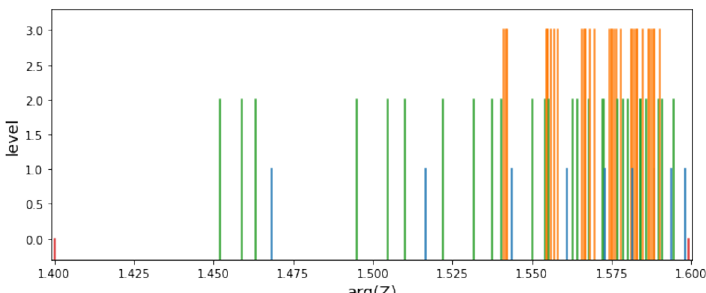
Figure 16 . States between γ and lvlcut = 3 . We plot the phase of the states on the horizontal axis against their level on the vertical axis and also colour them by